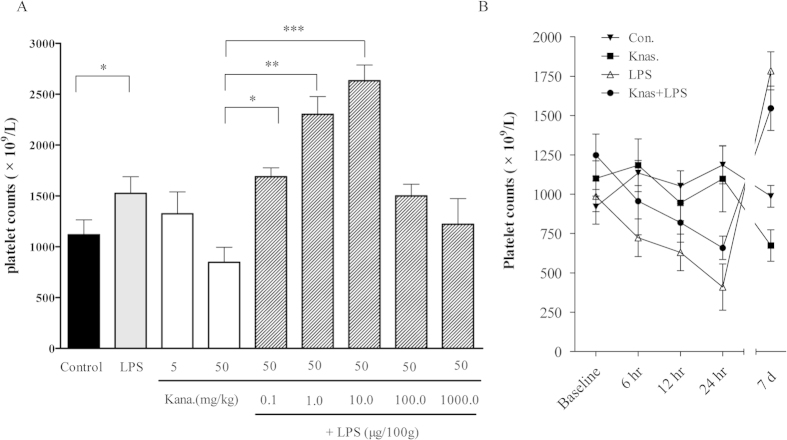
Effect of LPS on circulating platelet counts in mice.(A) Circulating platelets in kanamycin-treated (5, and 50 mg/day) and kanamycin plus LPS-treated (0.1, 1.0, 10.0, 100.0 and 1000.0 μg/100 g/day) mice for 10 d. Platelet counts with LPS IP (0.1, 1.0 and 10.0 μg/100 g/day) were significantly increased compared with the control (P < 0.05) in a dose-dependent manner. (B) The respective time curve represents the mice recorded at 3, 6, and 24 h and 7 d after the termination of treatments. Platelet counts slightly decreased after 7 d of kanamycin injection. The IP injection of LPS restored the platelet numbers after 7 d in kanamycin-pretreated mice. In contrast, LPS reduced the circulating platelet count in 24 h.